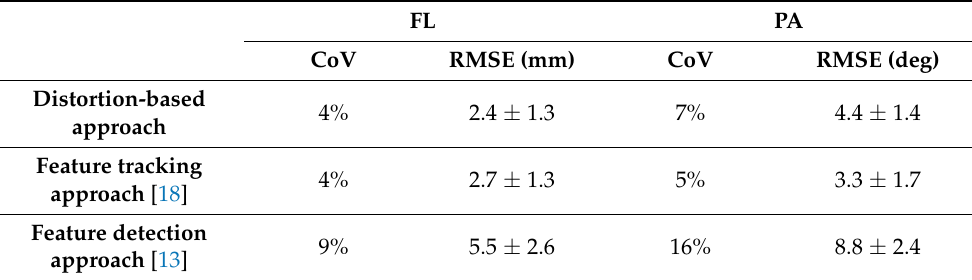
Table 1. Coefficient of variation (CoV) and average root mean square error (RMSE) between manual and automated measurements of fascicle length (FL) and pennation angle (PA). Results for the proposed distortion-based approach are compared against feature detection and feature tracking methods from